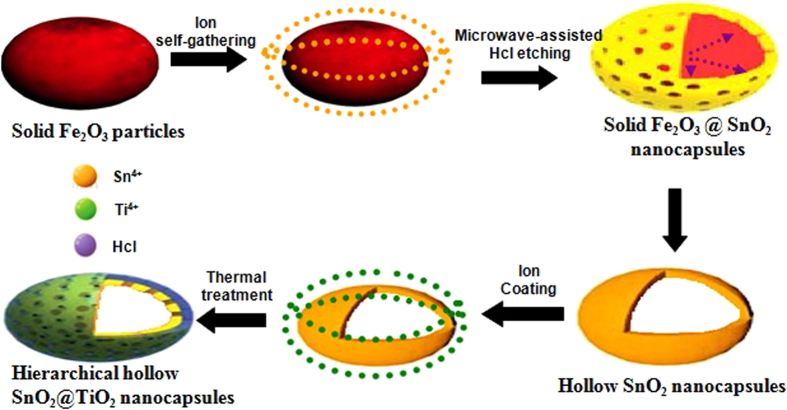
Representative illustration of the formation of hierarchical hollow SnO2@TiO2 nanocapsules by the microwave-assisted etching of Fe2O3 template.(This figure is drawn by L.X.L.).